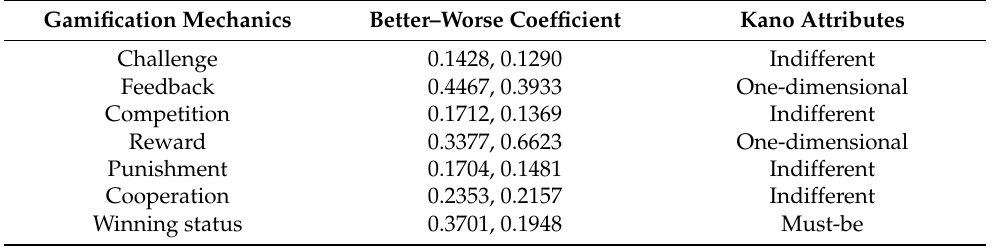
Table 2. Analysis of Kano questionnaire